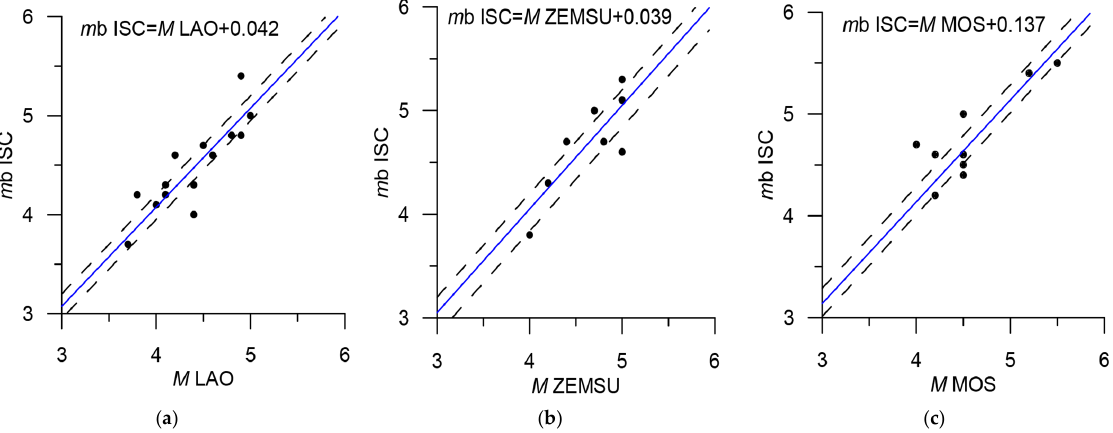
Figure 19. Poorly defined “shift” correlations with the magnitude mb ISC . ( a ) M LAO ; ( b ) M ZEMSU ; and ( c ) M MOS . The dashed lines show 95 % confidence intervals.